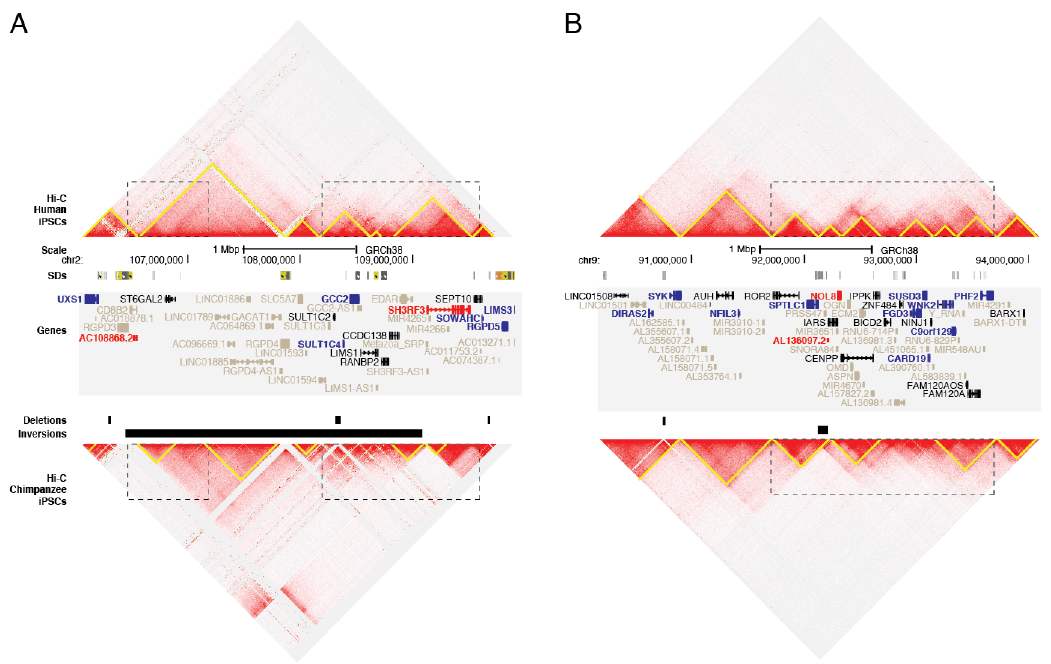
Figure 4. Genome organization of human and chimpanzee across regions with identified SVs. The Hi-C genomic landscape of human (top) and chimpanzee (bottom) are depicted for iPSCs using Juicebox for ( A ) chromosome 2q12.2-q13 (chr2:106095001-109905000, GRCh38) and ( B ) chromosome 9q22.2-q22.32 (chr9:90200001-94010000, GRCh38). Predicted TADs (yellow triangles) were compared between species, noting di ff erences at SVs (dotted boxes) including deletions and inversions. SDs are depicted as colored bars, taken from the UCSC Genome Browser track. Genes showing significant DE in chimpanzee versus humans are colored as red (up in chimpanzee) or blue (down in chimpanzee). Genes not included in the DE analysis are in gray (Tables S11 and